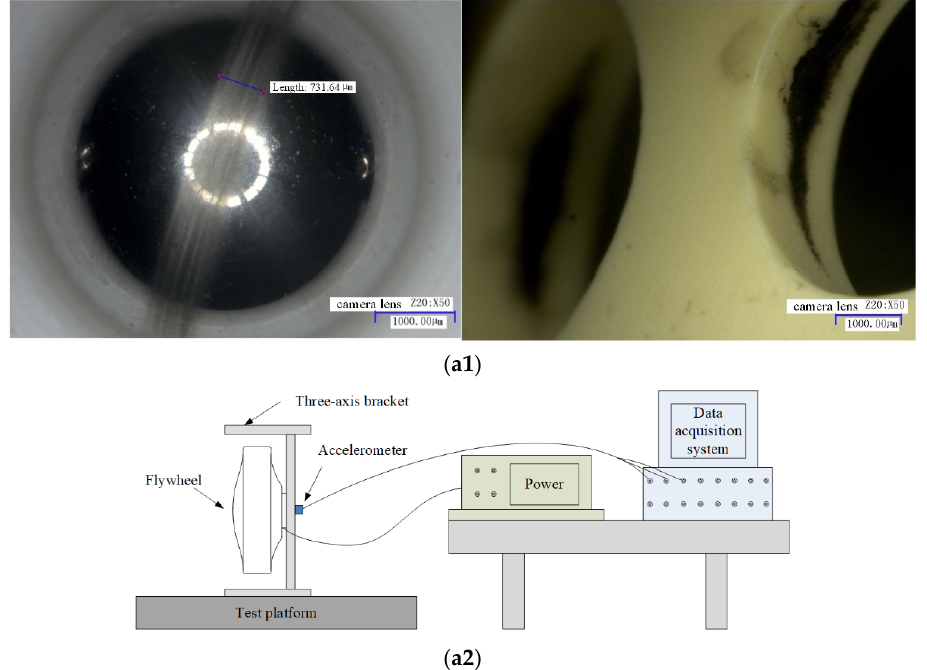
Figure 35. ( a1 ) Disassembly diagram. ( a2 ) Diagram of test rig. Table 3. Bearing characteristic frequencies of test bearings.